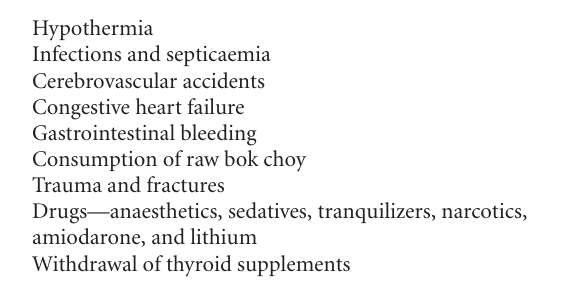
Box 1: Precipitating factors of myxedema